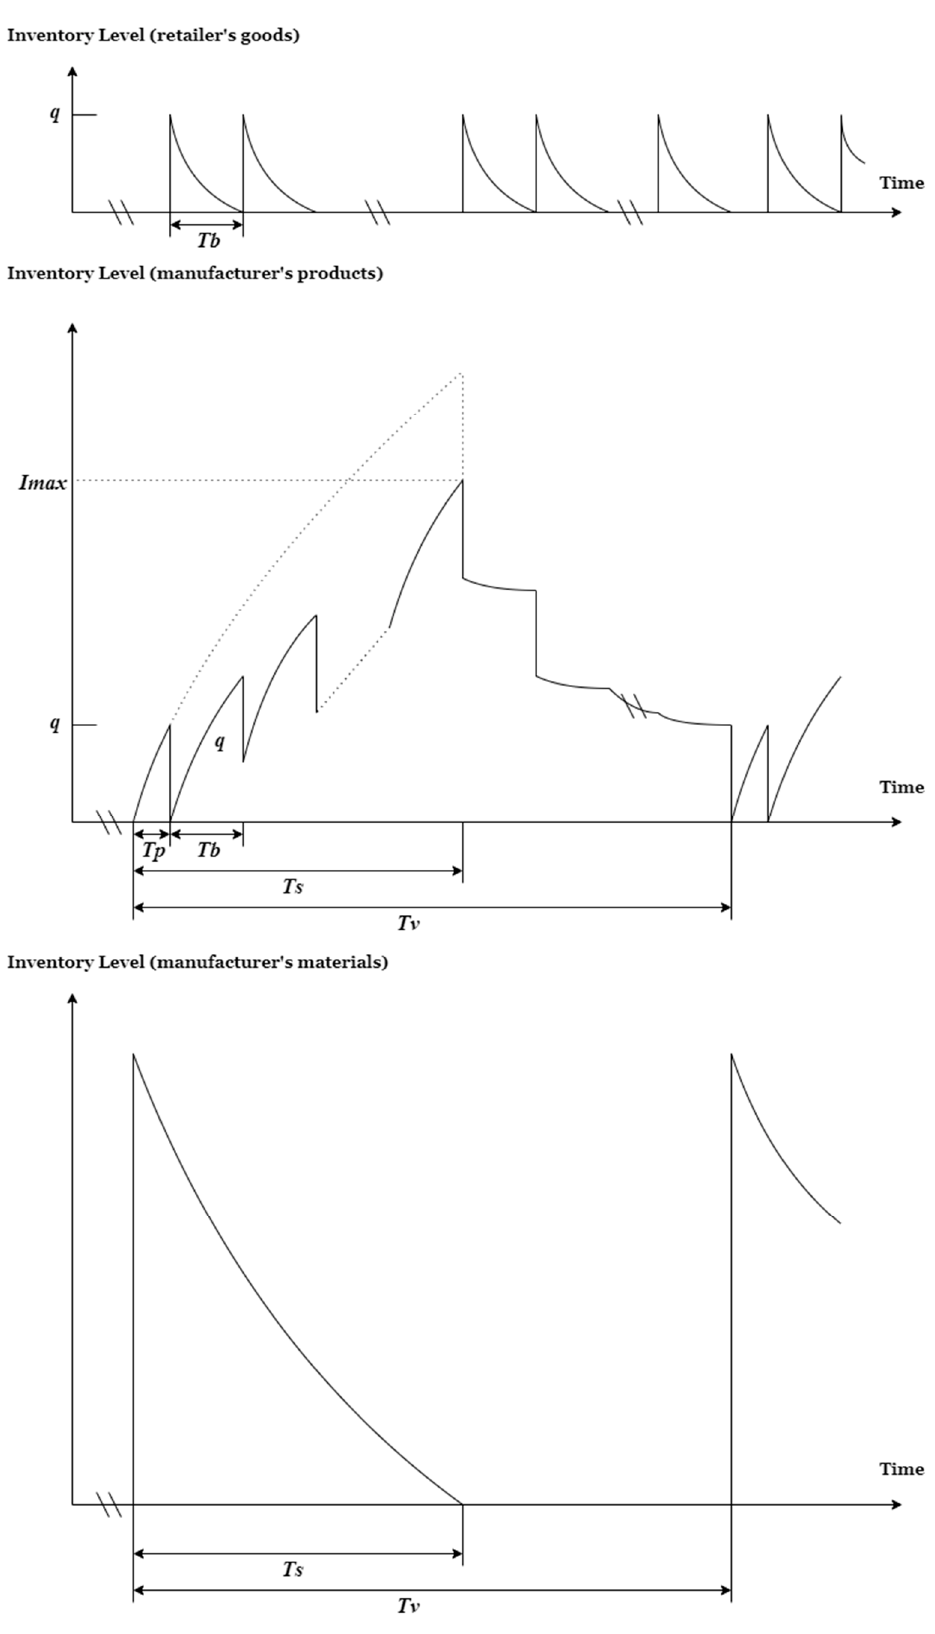
Figure 2. Inventory levels of materials and finished goods in a complete production cycle.